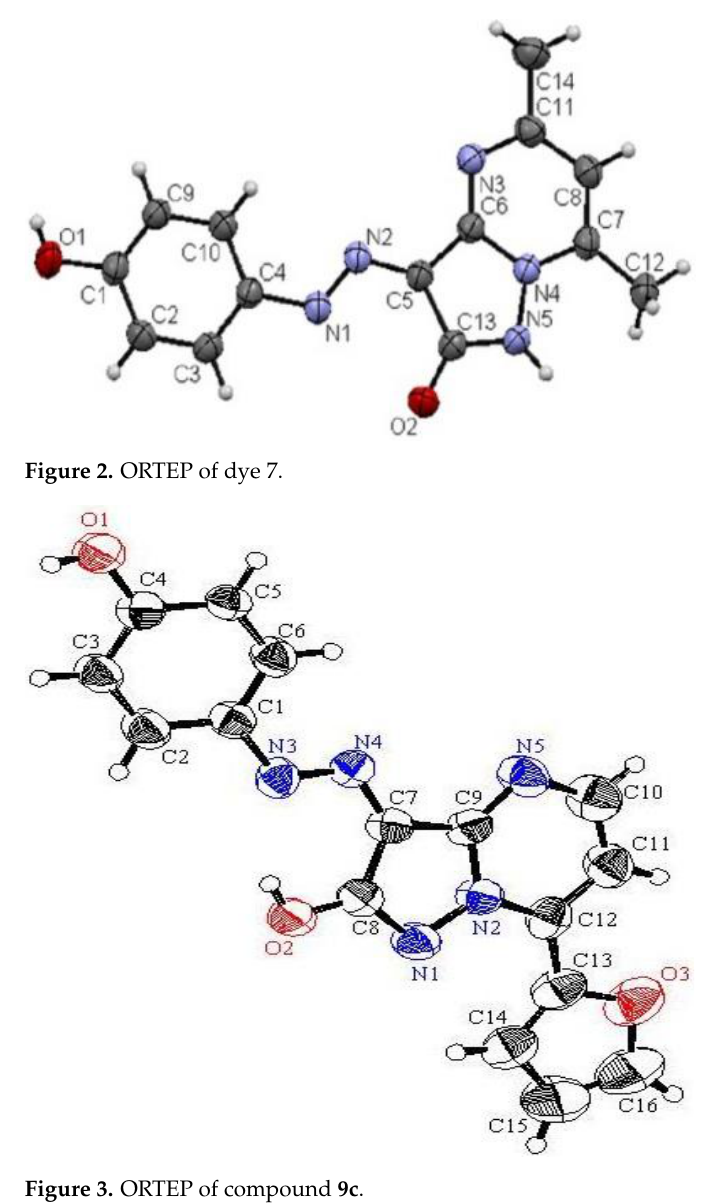
Figure 3. ORTEP of compound 9c .